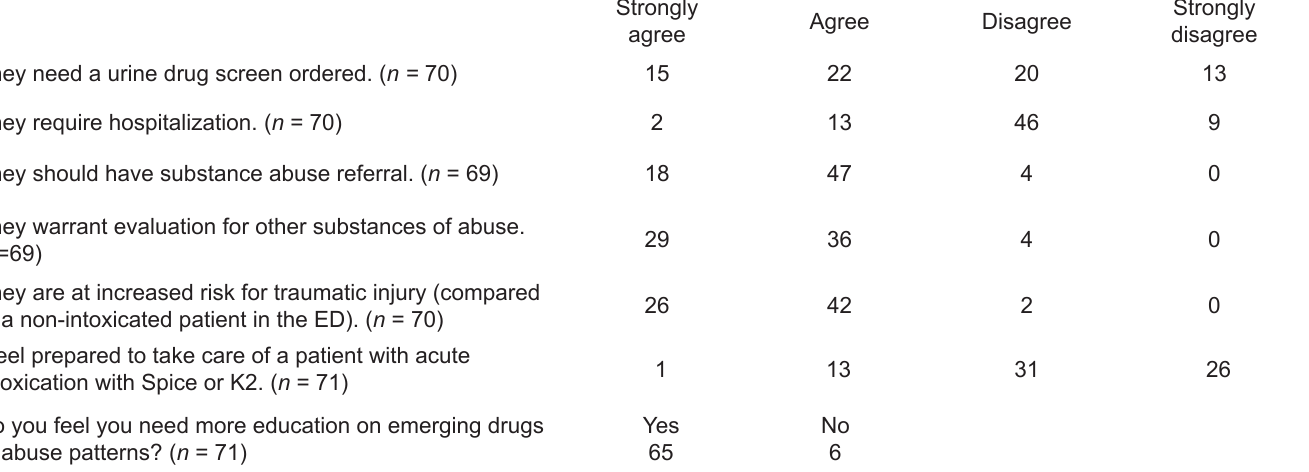
Table 2 . Clinical practice patterns. a,b